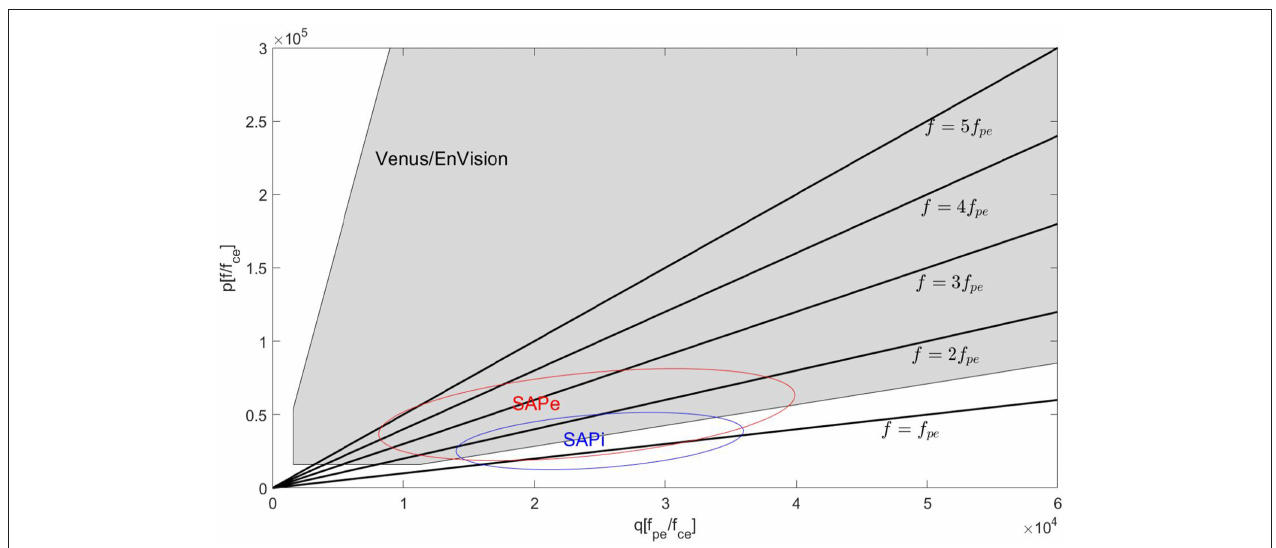
Frontiers in Astronomy and Space Sciences |